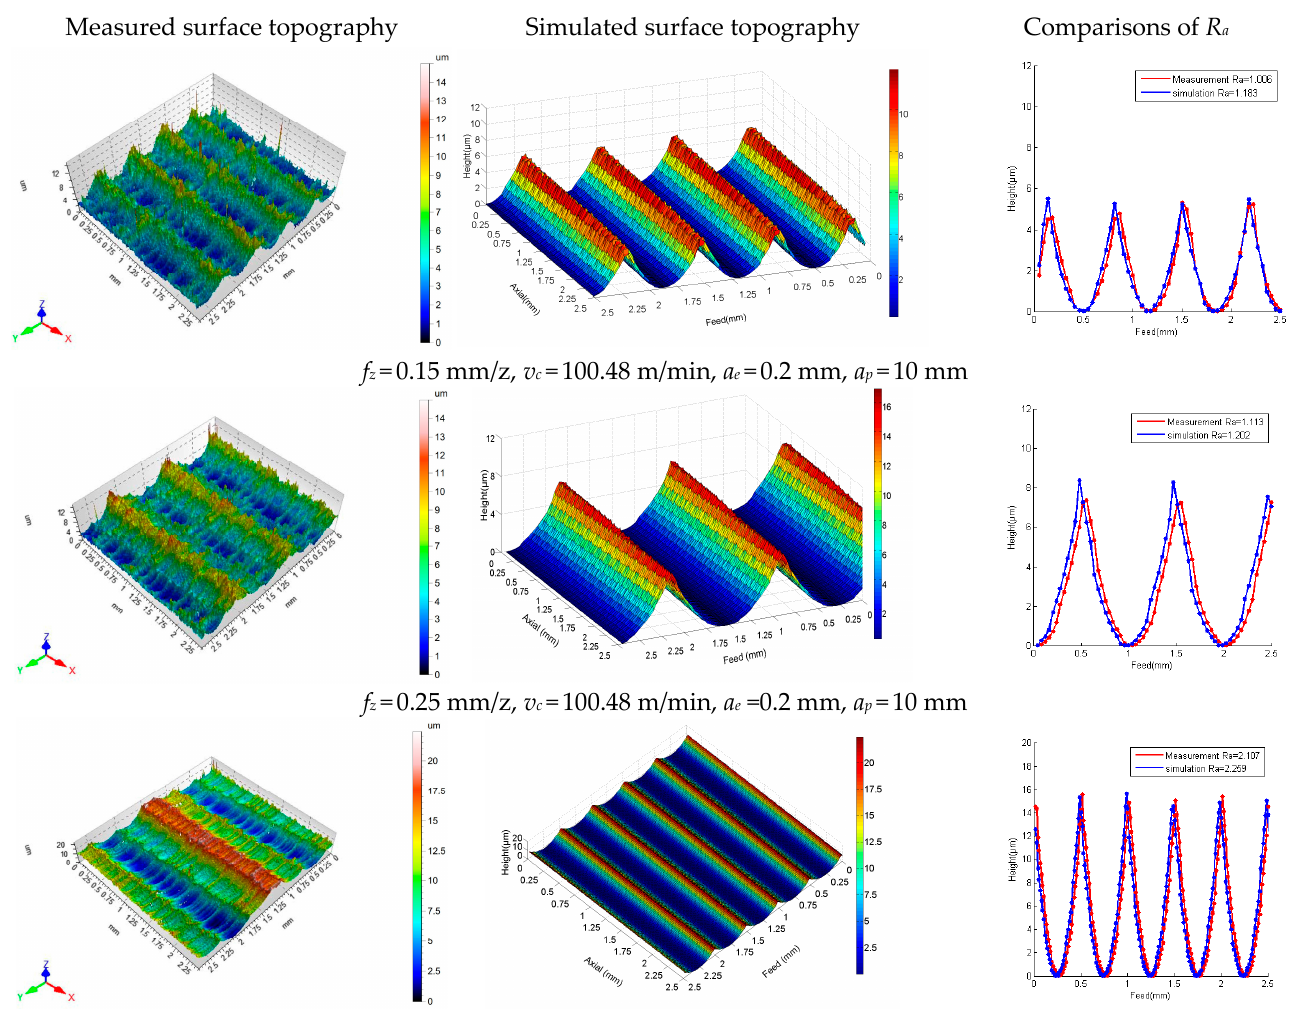
Figure 15. Surface topography with different feed rate of each tooth. From the geometric point of view, the increase in radial cutting depth a e will increase the height of the residual body on the machined surface in the intermittent feeding direction, so the surface roughness characterization parameters S a will increase with the increase in a e . At the same time, radial cutting depth a e affects the dynamic displacement of the tool and workpiece by affecting the physical factors such as cutting force and cutting stability, and finally indirectly affects the surface topography of parts. It can be seen from Figures 13c and 16 that when the radial cutting depth a e is greater than 0.5 mm, the dynamic displacement of the milling system increases sharply and the S a deviation value of the milling surface becomes larger and larger. The simulated values of R a have an average error of